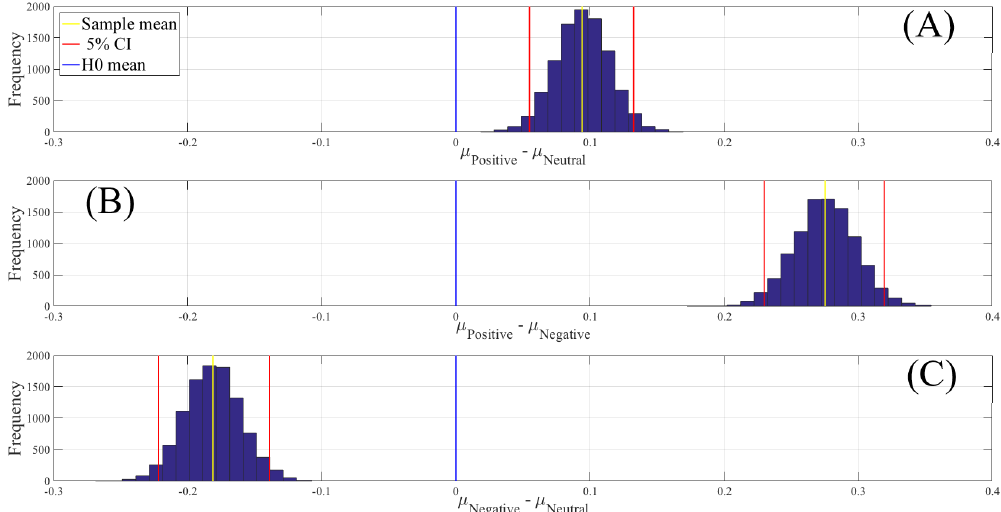
Figure A4. Paired two-sample bootstrap test of significance (10,000 simulation runs) at 95.0% confidence interval (CI) associated with the participants’ MSE1s (i.e., 62 MSE1s associated with 62 EEG channels of a participant, per affect). Compared pairs of mental states are: ( A ) positive versus neutral, ( B ) positive versus negative, and ( C ) negative versus neutral. X-axis: difference between average values of two affective states (e.g., positive versus negative). Blue line: non-significant difference between MSE1s of two different affective states. Red lines: 95.0% confidence interval boundaries. Yellow line: average two affetective states’ mean differences over 10,000